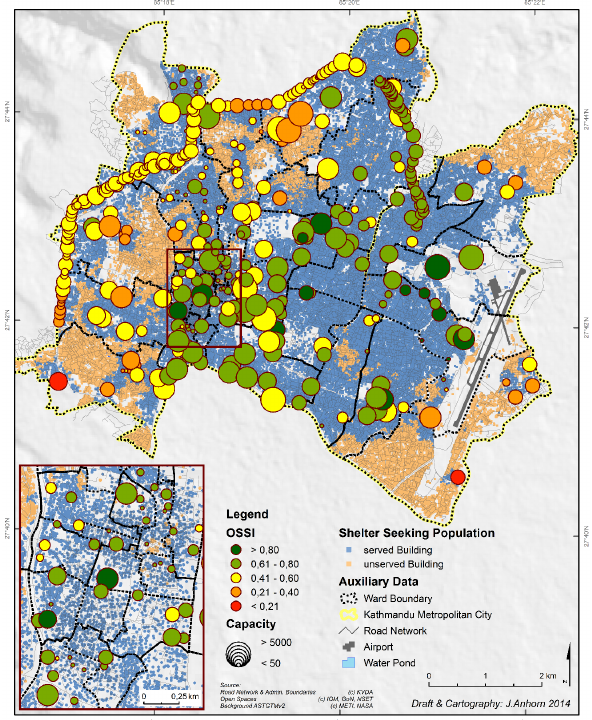
Figure 5. Spatial representation of the Open Space Suitability Index for Kathmandu Metropolitan